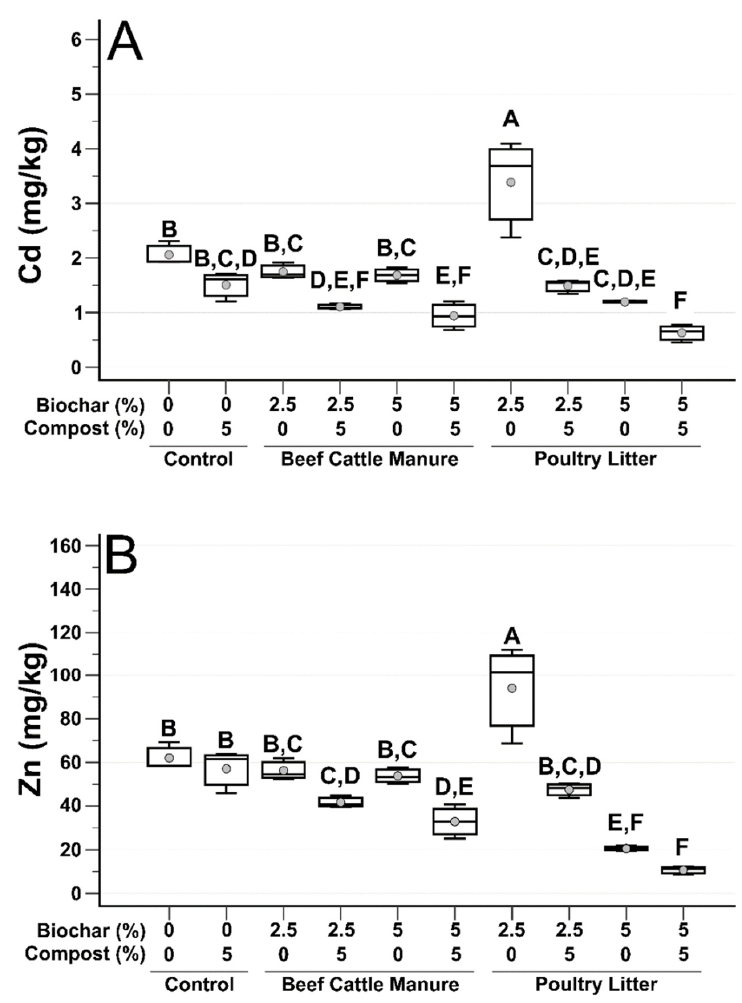
Figure 1. Box and whisker plots of soil Cd ( A ) and Zn ( B ) post treatment. Gray circles are mean values, top and bottom of boxes are 75th and 25th percentile, respectively, median is center line, and whiskers are range of the data. Treatments that do not share a letter are significantly different ( p < 0.05). Table 1. Soil pH and EC means and standard errors.